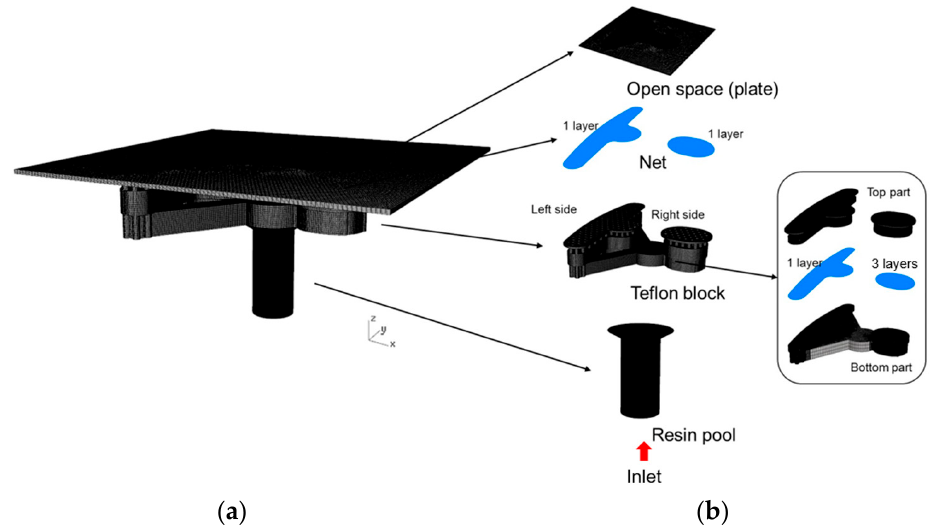
Figure 9. The design of Case 2. ( a ) The overall design of Case 2 and ( b ) the individual design of the plate, the fine mesh nets, the Teflon block, and the resin pool of Case 2.